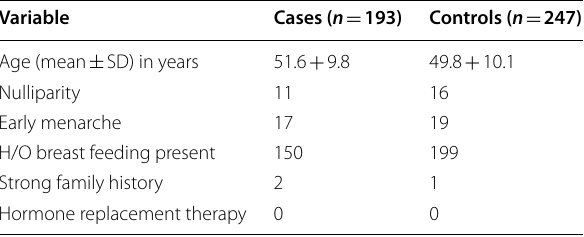
Table 5 Comparison of Case and control groups on the basis of clinical and demographic features